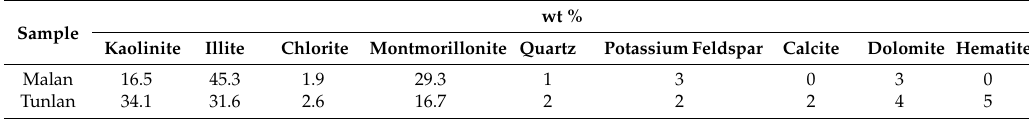
Table 3. The preliminary result of water sample.